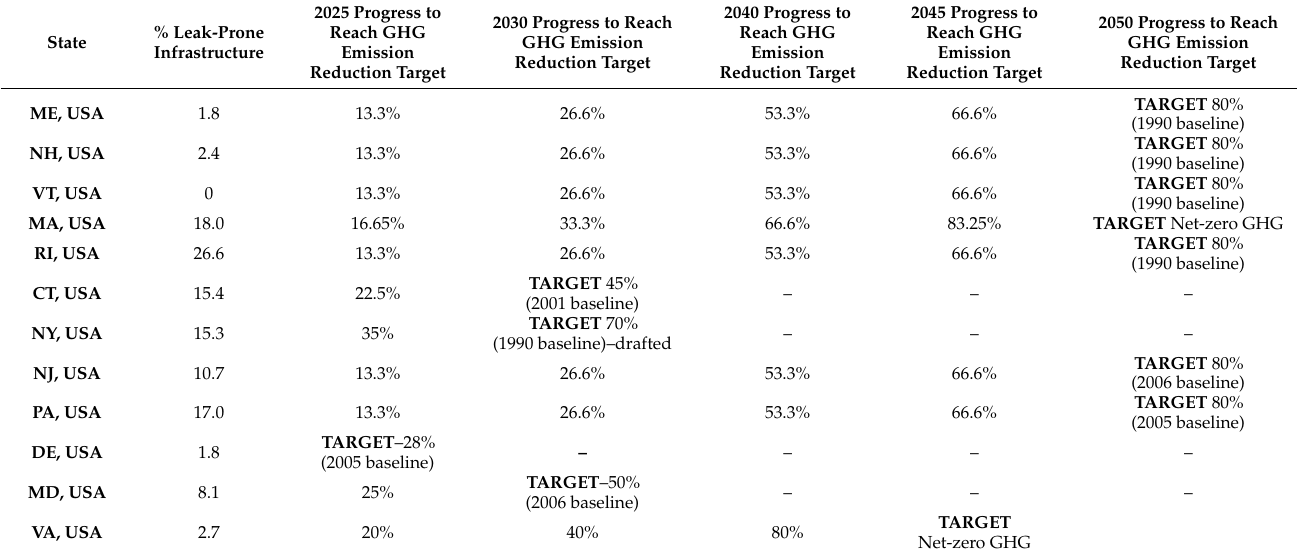
Table 3. For each of the 12 states across the BosWash corridor, the % of leak-prone natural gas infrastructure in the state is presented from 2020 PHMSA datasets [69]. The GHG emission reduction goals and the year by which these targets will be achieved are outlined and benchmark goals are pro- rated to compare progress requirements across states from 2025 to 2050 [85–96]. Many of the states have a target emission reduction deadline in 2050, defining the upper bound for pro-rating progress. Included are the baseline emission values for each state for which to base the percentage